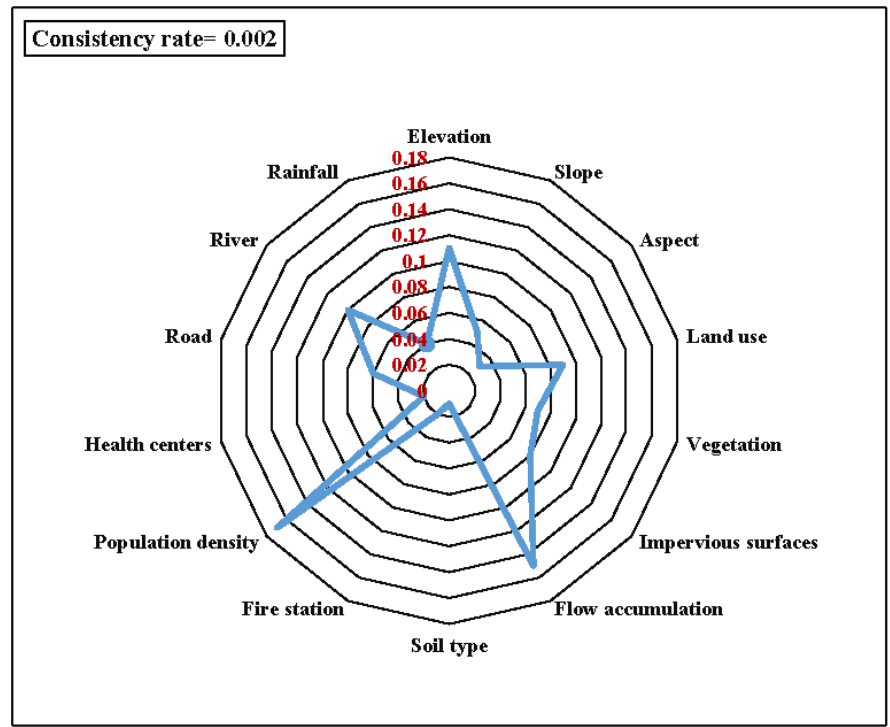
Figure 4. Weight and importance of criteria affecting flood